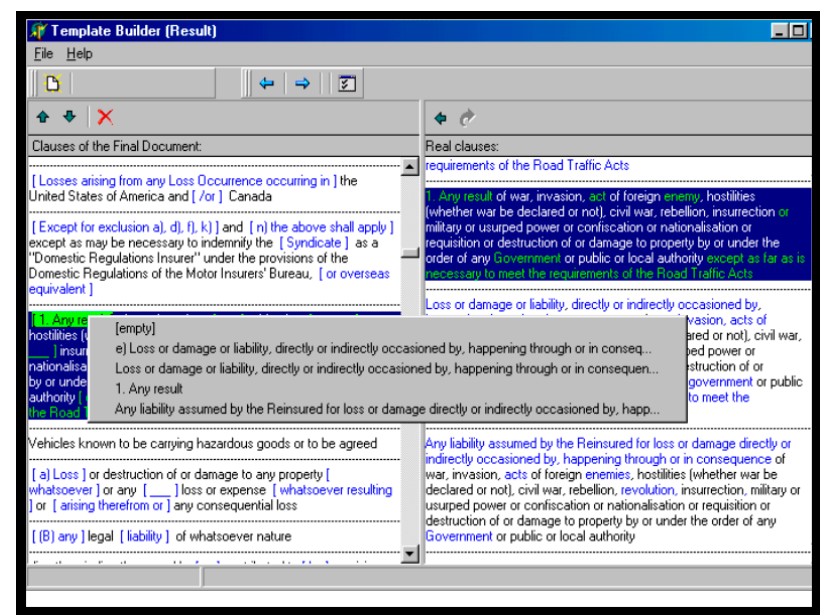
Figure 10. Formation of a template based on the key clauses in a cluster of contracts.